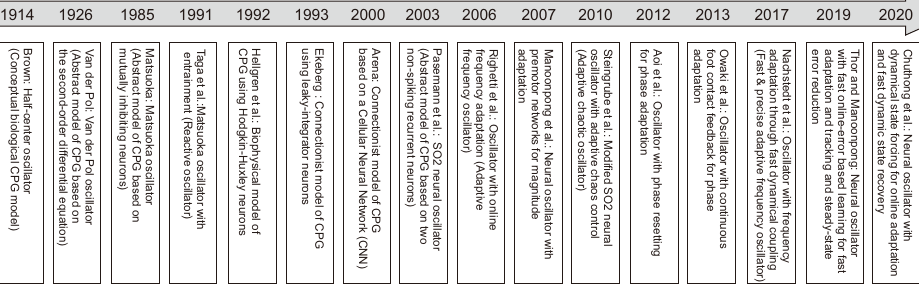
Figure 7. Timeline of the development of various CPG models from 1914 to 2020.The key CPG models include a half-center oscillator in 1914 [172], the Van der Pol oscillator in 1926 [177], the Mat- suoka oscillator in 1985 [178], the Matsuoka oscillator with entrainment in 1991 [179], a biophysical oscillator based on Hodgkin–Huxley neurons in 1992 [173], a connectionist oscillator based on leaky-integrator neurons in 1993 [174], a connectionist oscillator based on a cellular neural network (CNN) in 2000 [175], an SO2 neural oscillator in 2003 [176], an adaptive frequency oscillator (AFO) in 2006 [180], a neural oscillator with magnitude adaptation in 2007 [49], an adaptive chaotic os- cillator in 2010 [141], an oscillator with phase resetting [181], an oscillator with continuous phase modulation [182], an oscillator with frequency adaptation through fast dynamical coupling (AFDC) in 2017 [183], a neural oscillator with fast online-error based learning in 2019 [184], and a neural oscillator with dynamical state forcing (DSF) in 2020